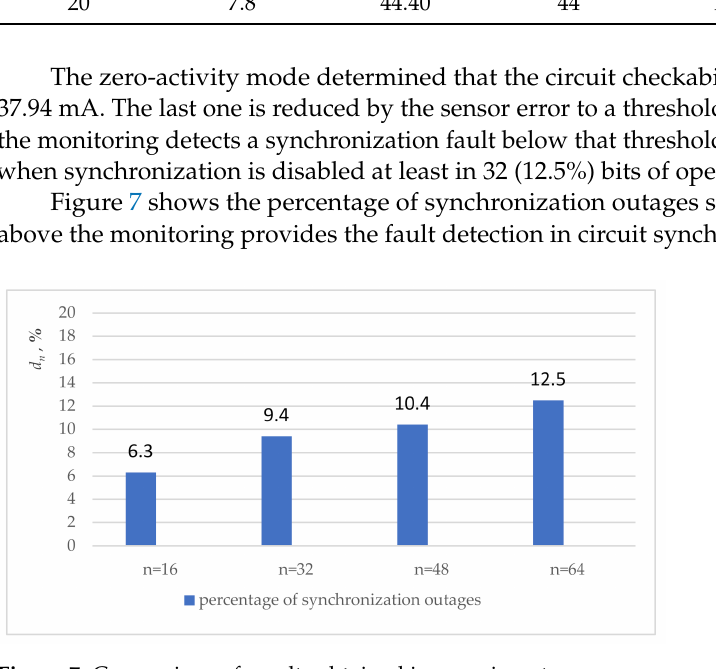
Figure 7. Comparison of results obtained in experiments. For example, for n = 16 the sync fault is detected when 6.3% of the sync inputs are disconnected and with a higher percentage of